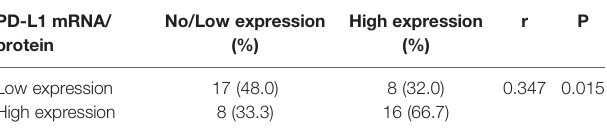
TABLE 6 | Spearman ’ s correlation analysis between PD-L1 mRNA and protein expression in EOC patients carrying different genotypes of rs2297136. PD-L1 mRNA/ No/Low expression protein